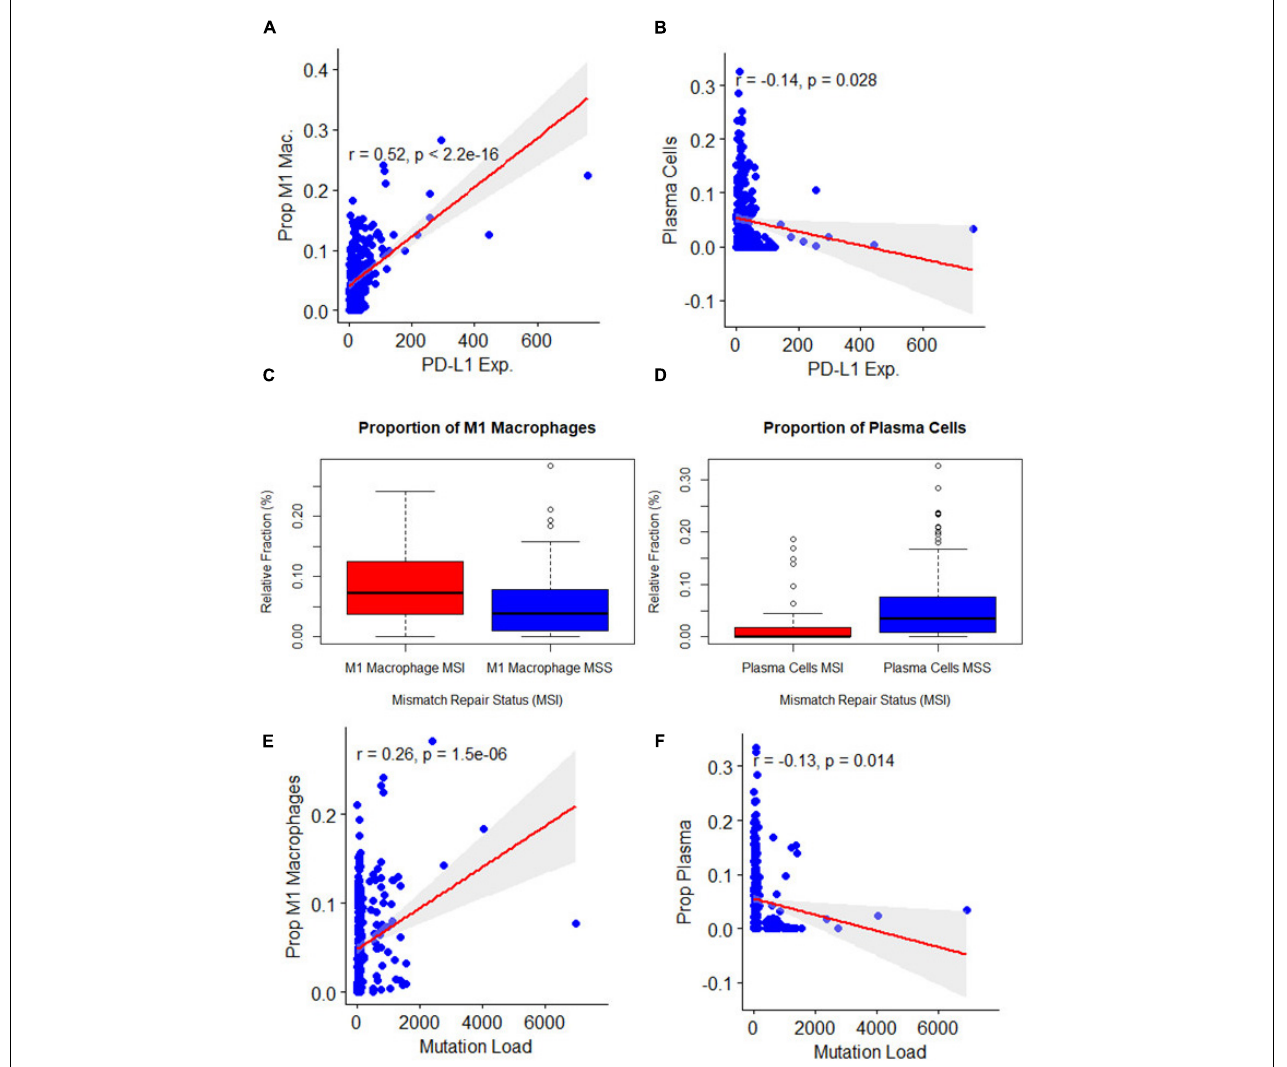
FIGURE 2 | Association of clinical features related to immunotherapy with immune cell types (A,B) . Association of microsatellite instability status with: M1 macrophage polarization ( p = 0.00) and plasma cells ( p = 0.00). (C,D) Association of programmed death-ligand 1 expression with: M1 macrophage polarization ( p = 0) and plasma cells ( p = 0.03), y axis represented the immune cell deconvolution results as fraction relative to the immune-cell content: M1 macrophage and plasma cells. (E,F) : Association of mutation burden with: M1 macrophage polarization ( p = 0.00) and plasma cells ( p = 0.01).